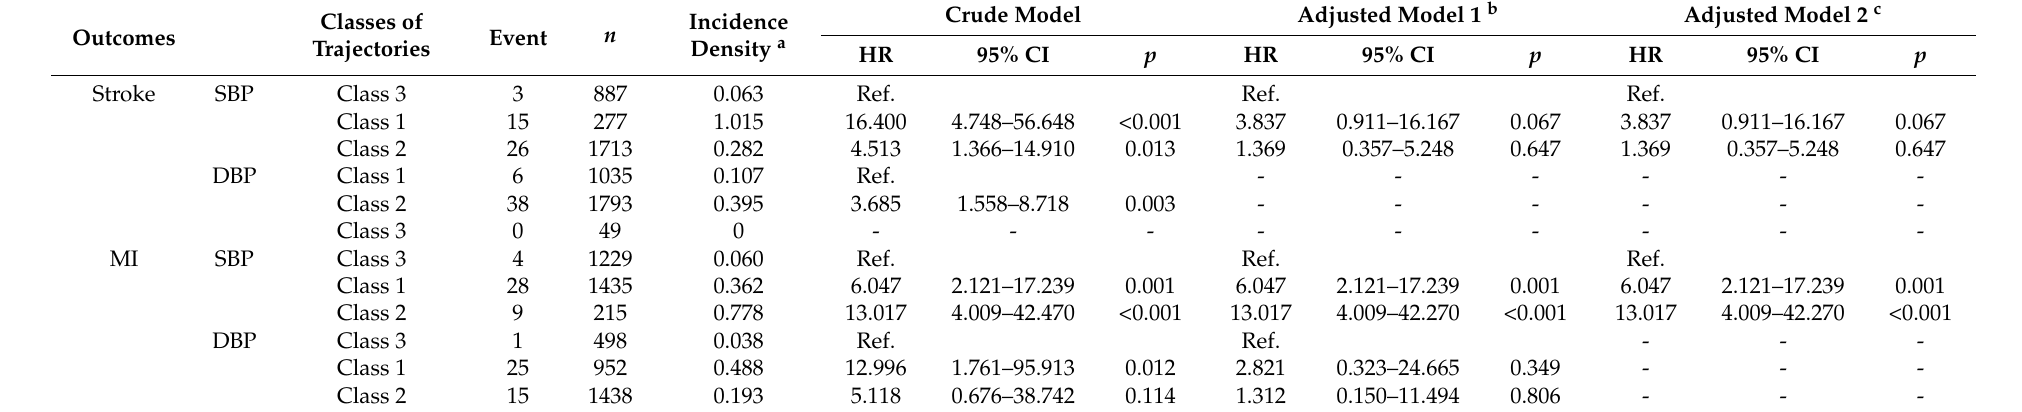
Table 4. The associations between blood pressure trajectories and stroke or myocardial infarction (MI) by cox